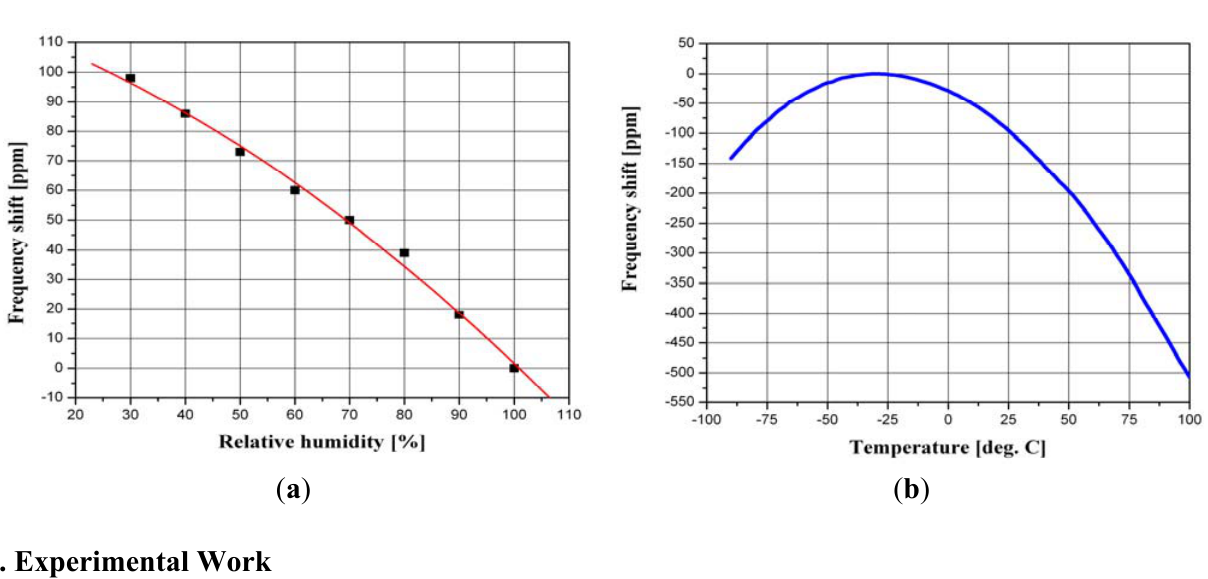
Figure 3. ( a ) Humidity sensing characteristic of a 150 nm hexamethyldisiloxane (HMDSO) polymer coated RSAW resonant sensor and ( b ) its temperature frequency characteristic over a ( − 80 to +100) °C temperature